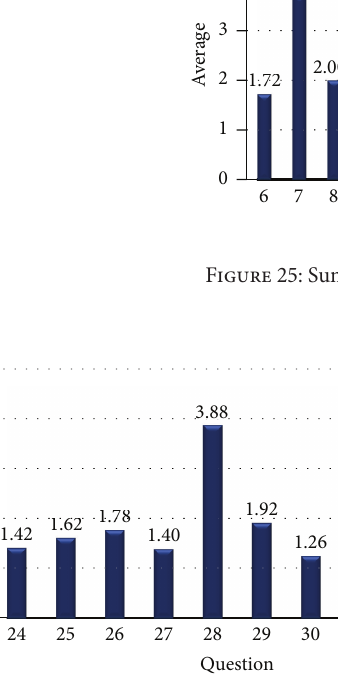
Figure 26: Summary of responses to student opinion survey